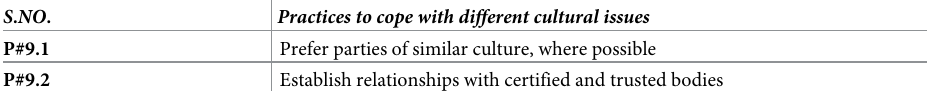
Table 12. Practices to cope with different cultural issues in COR.